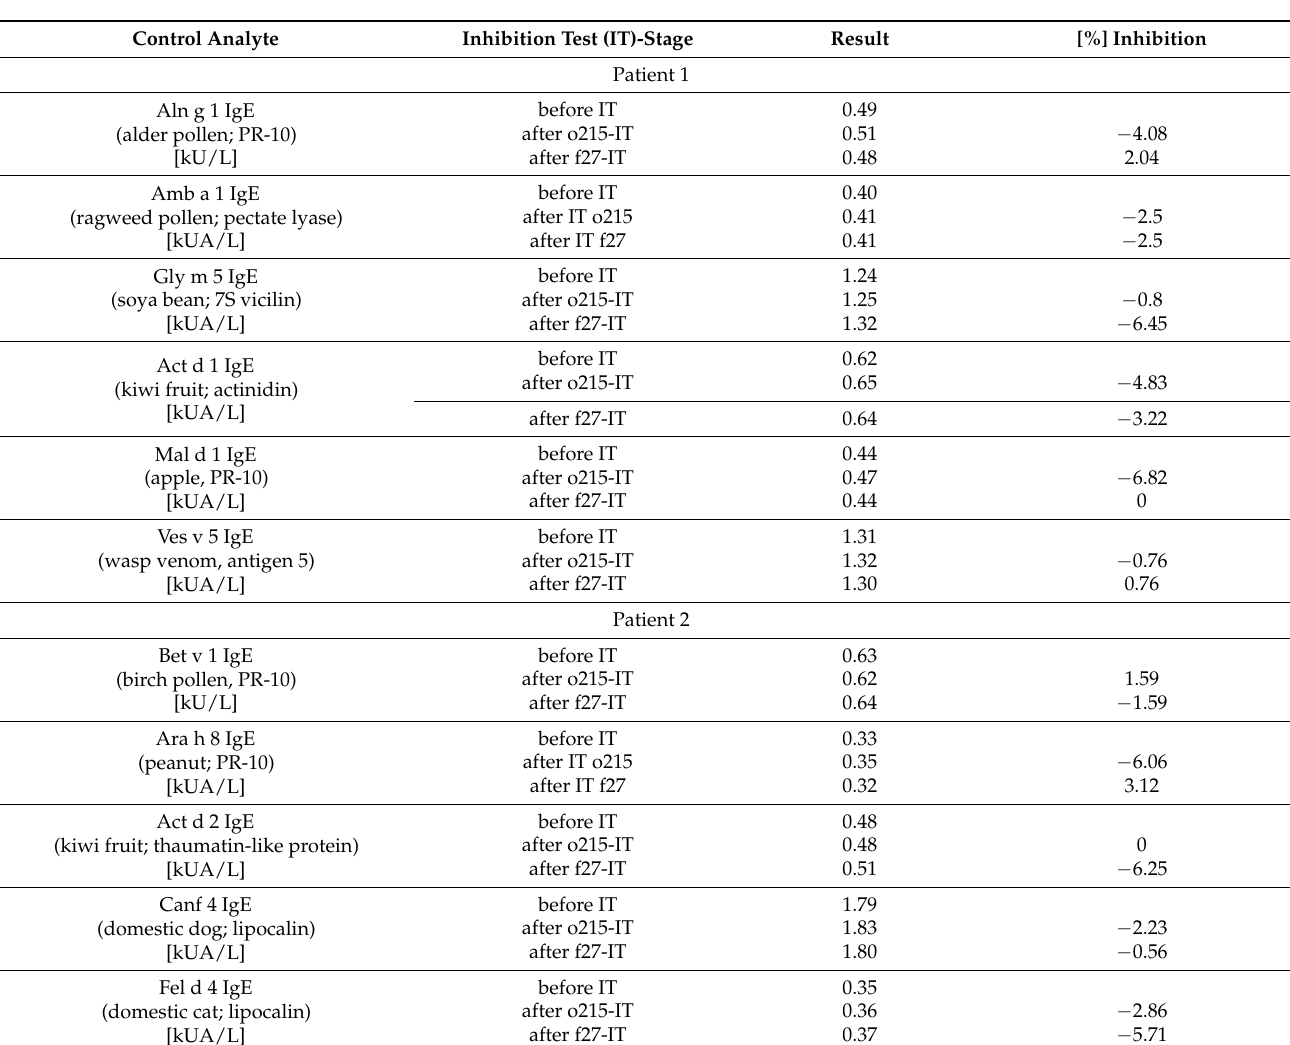
Table 2. Concentration and percentage changes in the concentration of specific IgE for allergens other than mammalian meat, poultry meat and α -Galibefore the inhibition tests on the ImmunoCAP o215 matrix (o215-IT) and the ImmunoCAP f27 matrix (f27-IT) and after the inhibition tests